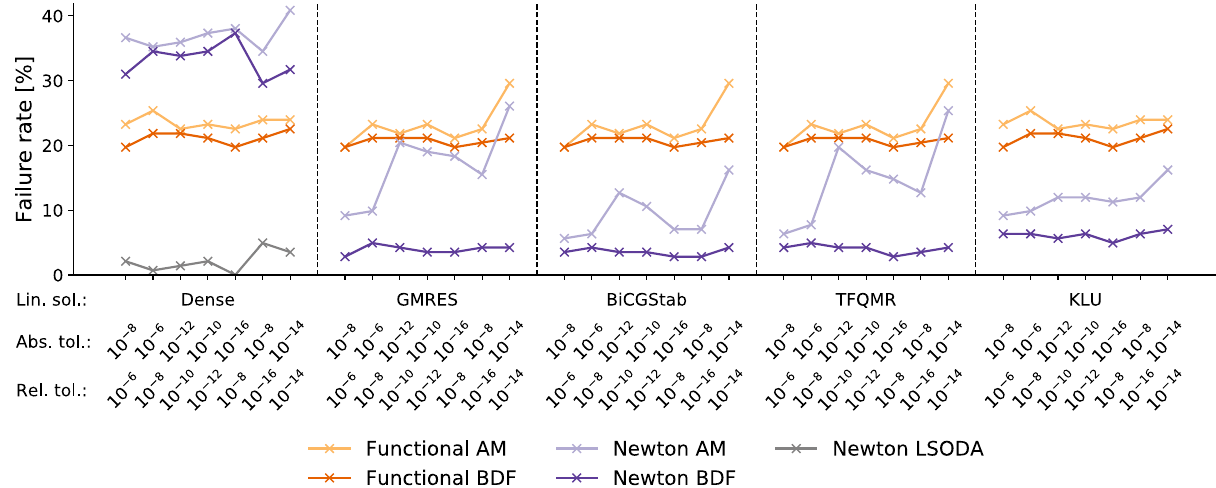
Figure 2. Non-linear solver. Comparison of functional and Newton-type non-linear solver in terms of failure rate. Each point represents the failure rate when simulating all models for a given combination of integration algorithm, non-linear solver, linear solver and error